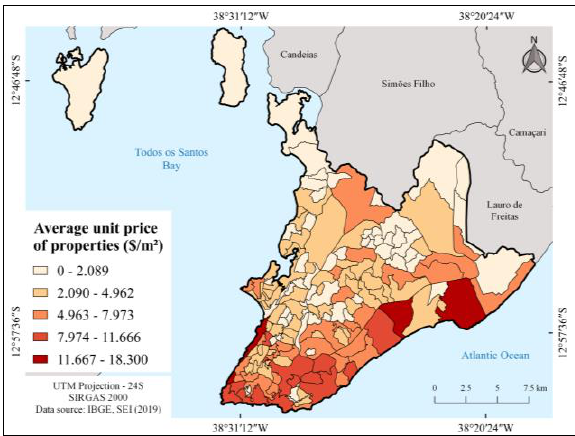
Figure 4 . Distribution map of average prices per m² of